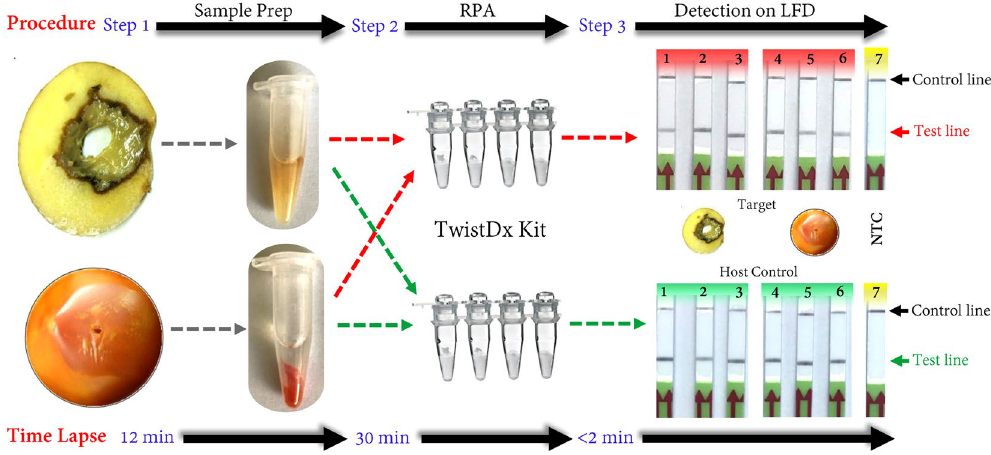
Figure 8. Schematic representation of direct detection of Pectobacterium sp. in infected host tissue using RPA-LFD and rapid sample prep with TE buffer. The results showed no inhibitory effect of plant inhibitors on RPA assay. The rapid sample prep using TE buffer takes about 12 mins. Each inoculated sample was tested with both Pectobacterium sp. specific RPA (upper; target) and host specific RPA (lower; host control). Color codes: red – detection of Pectobacterium sp. from Pectobacterium sp. infected potato tubers and tomato fruits; green – detection of host genome; yellow non-template control (NTC; water). Lanes 1–3 are potato tubers infected with Pectobacterium sp.; lanes 4–6 are tomato fruits infected with Pectobacterium sp.; lane 7 is NTC.